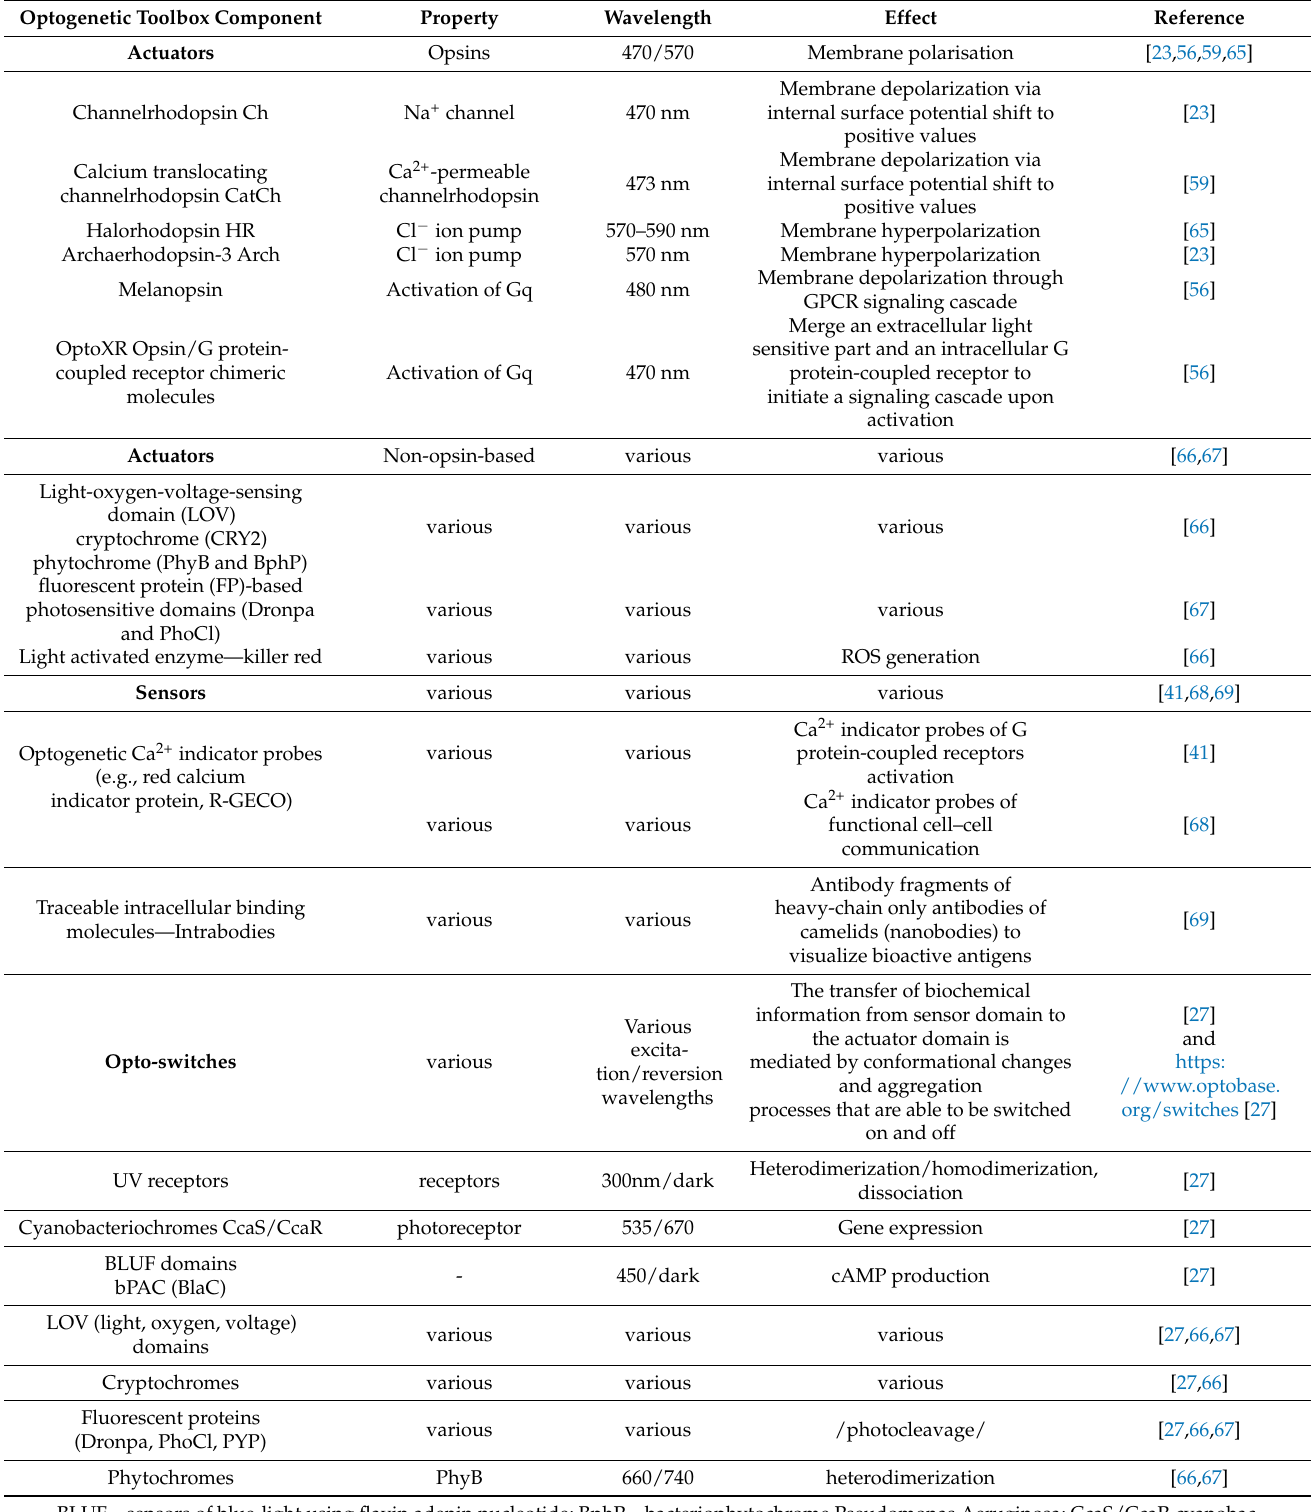
Table 3. Optogenetic toolbox relevant for